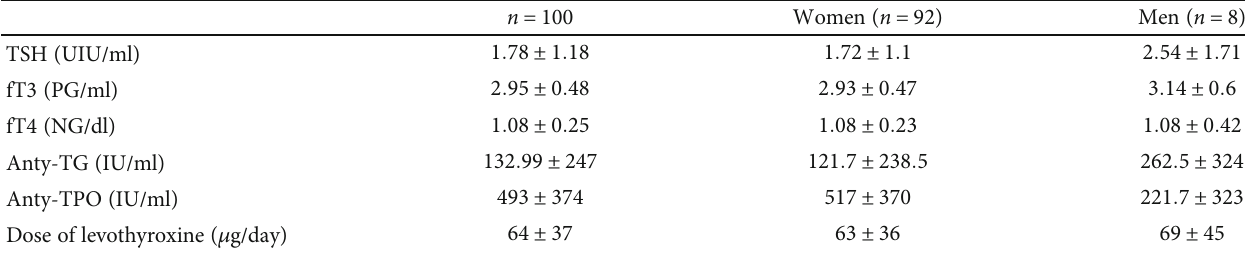
Table 2: Clinical characteristics of HT patients.